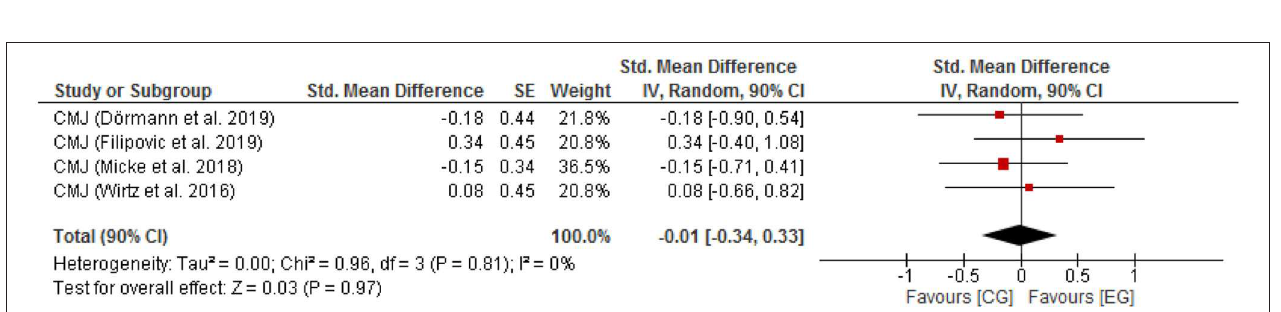
Frontiers in Physiology |